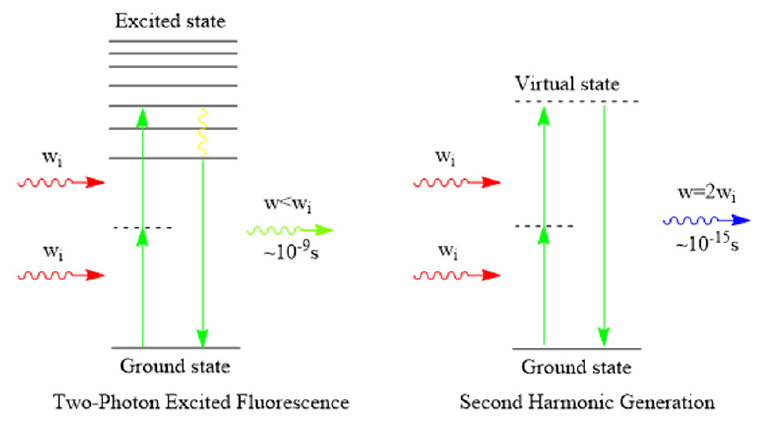
Figure 2. Two-photon excited fluorescence and SHG. Reprinted with permission from reference [84]. Copyright 2010, Proceedings of the National Academy of Sciences of The United States of